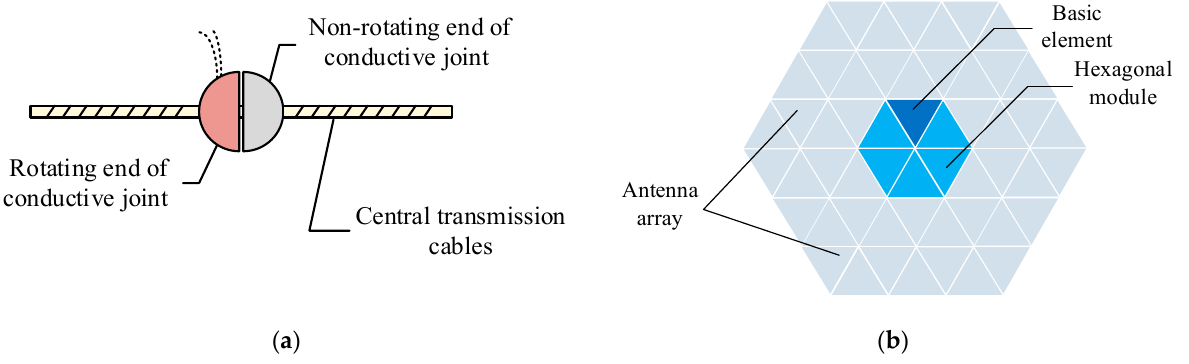
Figure 13. Detailed structure: ( a ) power management and distribution system; ( b ) transmitting antenna.